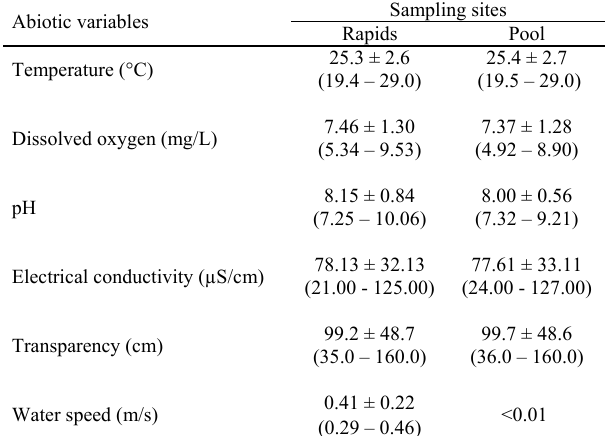
Table 2. Average values of the abiotic variables in different environments from October 2011 to March 2012. Variation amplitude is shown in brackets.